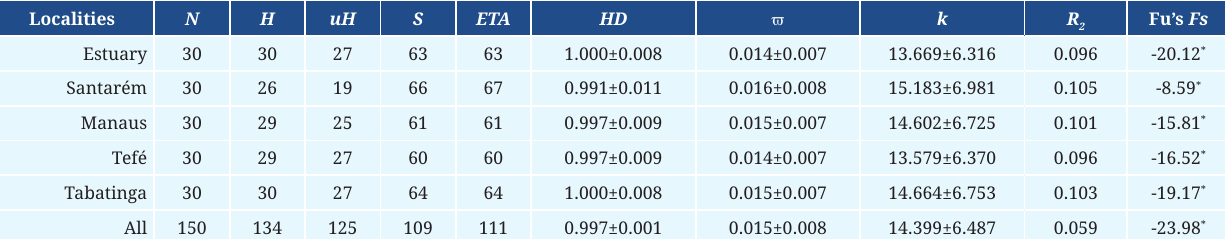
TABLE 1 | Summary of genetic parameters estimated from the Brachyplatystoma vaillantii mtDNA control region for five localities on the Solimões-Amazonas River. N = number of samples, H = number of haplotypes, uH = number of unique haplotypes, S = number of polymorphic sites, ETA = Total Number of Mutations sites, HD = haplotype diversity, π = nucleotide diversity, k = average number of nucleotide differences, * =